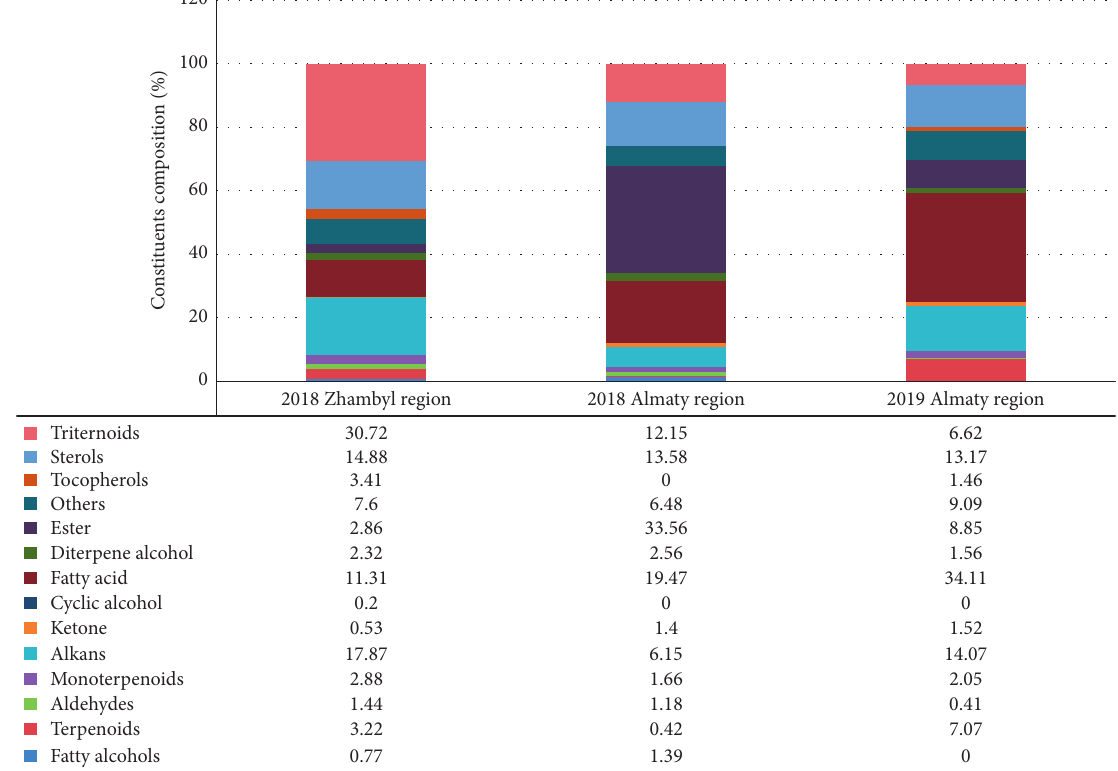
Figure 3: Ratio of main groups of substances in Portulaca oleracea ’s CO